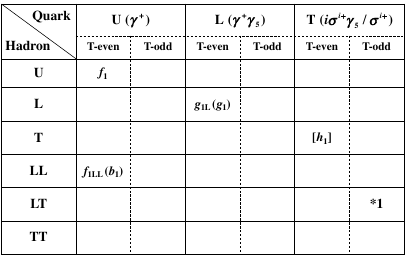
Table 4: Twist-2 PDFs.